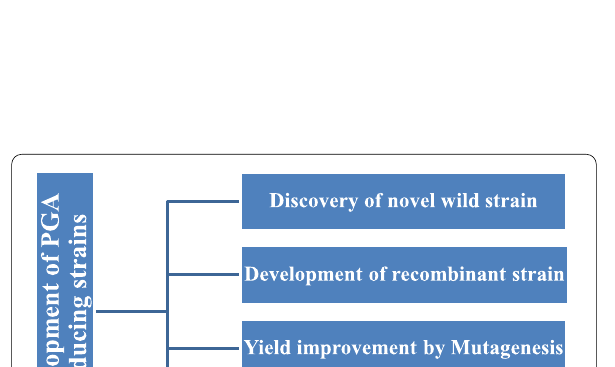
lular proteolysis and translocation were manipulated, and an appropriate host system with suitable cultiva- tion medium was selected. The cultivation of an E. coli strain BL21 (DE3), which is a natural deficient of ATP-dependent proteinase, Lon and outer membrane proteinase, OmpT [59], was done in a medium without a proteinaceous substrate that provided an increased PGA yield by 10-folds [38]. It has been studied earlier that PGA yields can be improved by the use of mini- mal medium with different carbon sources since it is